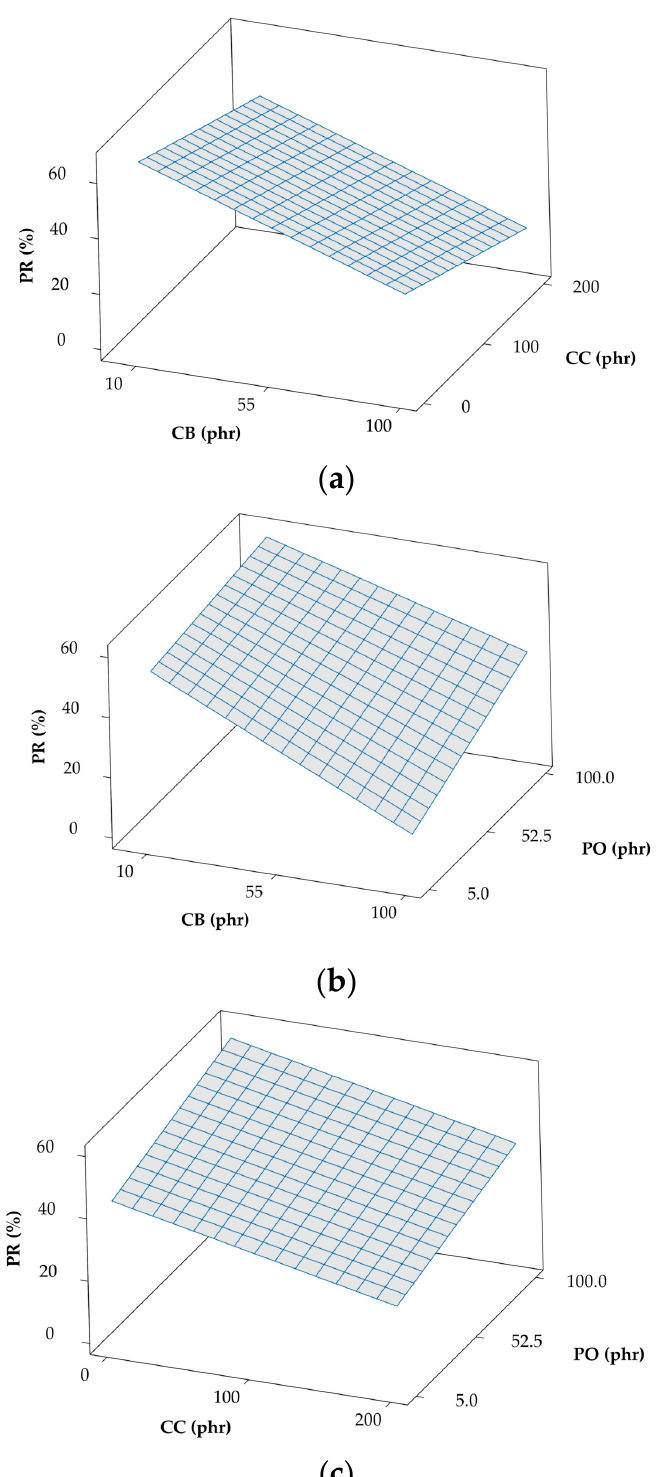
Figure 3. Response cross-correlation surface plots of percentage resilience (PR) with various combinations of additives: ( a ) CC and CB (PO held constant at 52.5), ( b ) PO and CB (CC held constant at 100), and ( c ) PO and CC (CB held constant at 55).